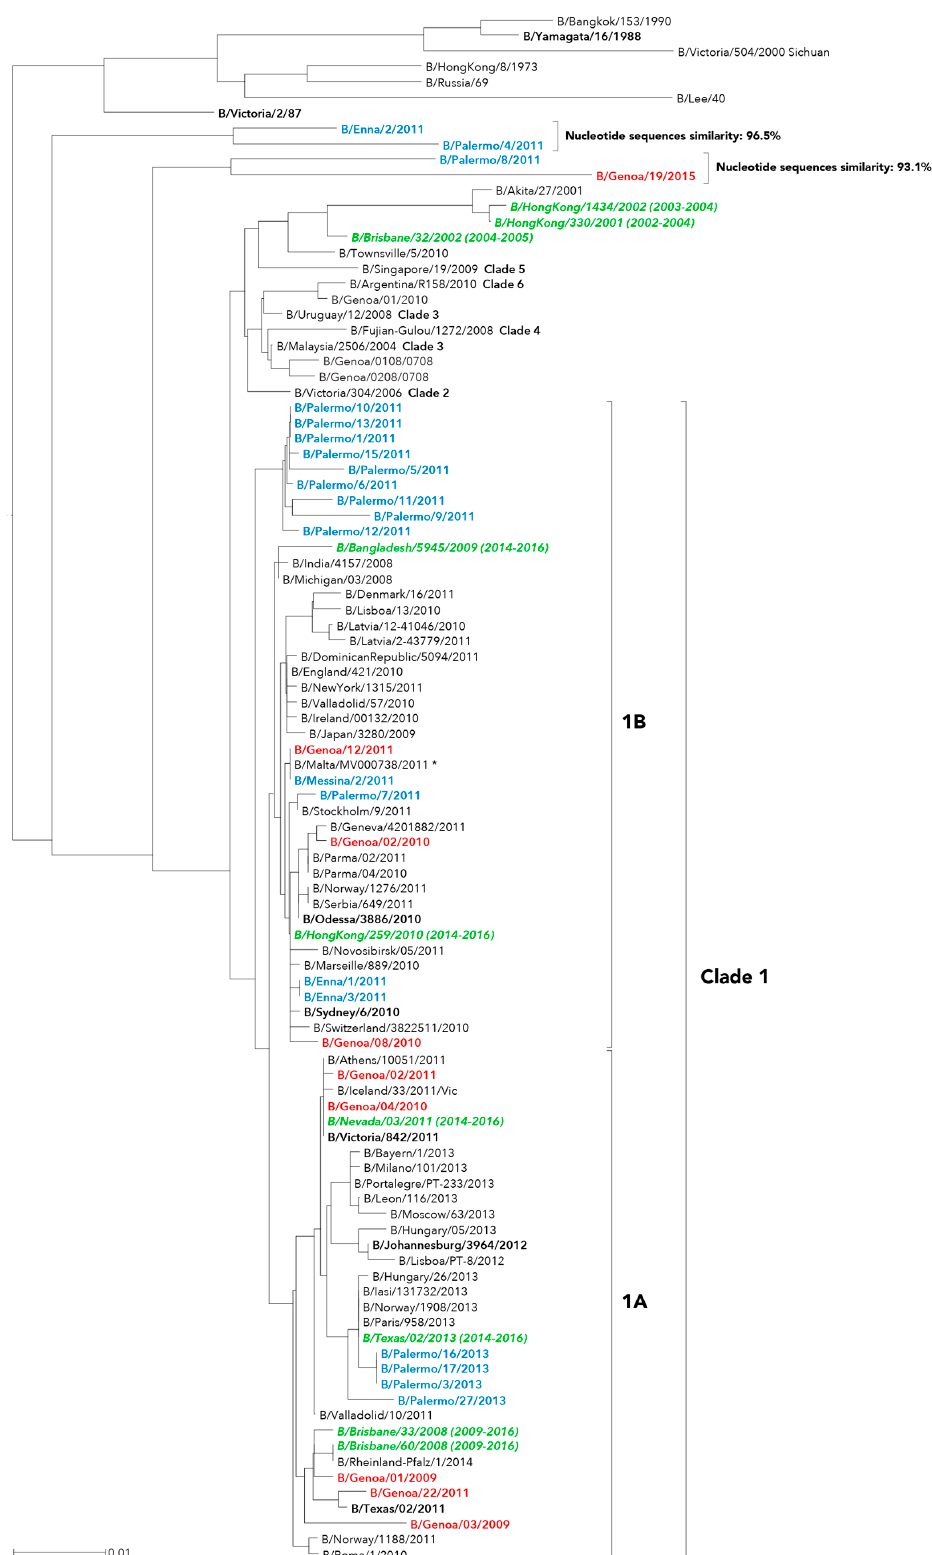
Figure 1. Phylogenetic analysis of the hemagglutinin (HA) nucleotide sequences from influenza B Victoria-lineage viruses isolated in Italy from 2010 to 2015. The phylogeny tree was generated by the neighbor-joining method with 1000 bootstrap replicates. Sicilian strains (blue color), Ligurian strains (red color), WHO recommended candidate vaccine (green color) and reference strains (black color, bold font).